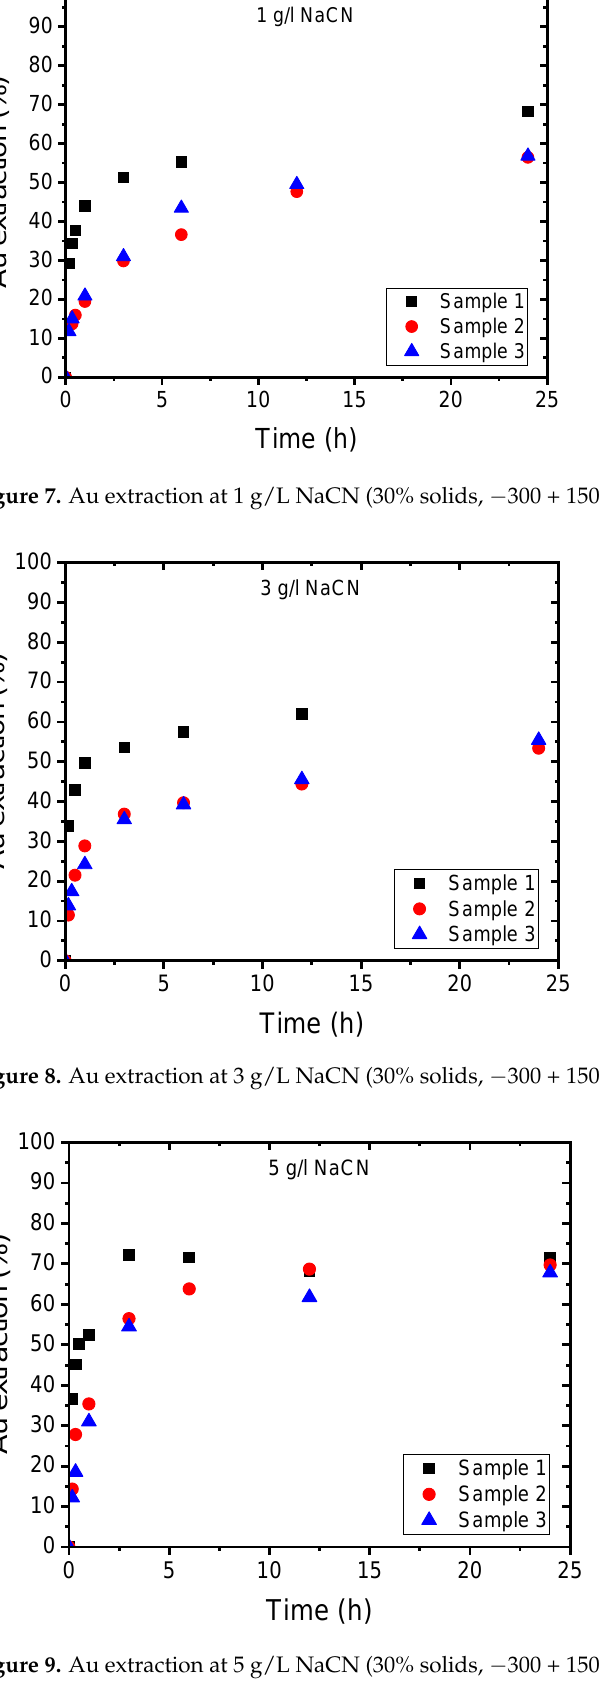
Figure 9. Au extraction at 5 g/L NaCN (30% solids, −300 + 150 µm PSD, 300 rpm, 26 °C). At 1 g/L NaCN, Sample 1 achieved the highest gold extraction at 68.2%, while Sample 2 and Sample 3 achieved 56.4% and 56.8%, respectively, after 24 h of leaching. At 3 g/L NaCN, Sample 1 still achieved the highest extraction at 62.0%, while Sample 2 and Sample 3 achieved 53.4% and 55.4%, respectively. Extractions at 3 g/L NaCN appear to be slightly lower than those achieved at 1 g/L NaCN. It should be noted that for Sample 1, at 3 g/L NaCN, gold extraction data were plotted only up to 12 h of leach time, as the leach sample at the 24 h mark was lost. At 5 g/L NaCN, Sample 1 reached an extraction of 71.6% while Sample 2 and Sample 3 achieved 69.7% and 67.8%, respectively. It can be observed, how- ever, that there is a slight decrease in gold concentration for Sample 1 at 5 g/L NaCN after 3 h of leaching. Sample 2 and Sample 3 (the higher-grade ores) showed similar initials kinetics at the three cyanide concentrations. 3.2.2. Reasons for Low Au Extractions The presence, in the three ores, of sulphide minerals that host gold can be a major reason for the low gold extractions achieved, since any gold hosted by these minerals would be locked and difficult to recover by conventional cyanidation. This was in fact confirmed by the diagnostic leach results which showed that, by the action of acids, the gold locked in sulphides could be extracted. In addition, sulphides of copper and iron such as pyrite, arsenopyrite, and chalcopyrite, which have been shown to be present in these ores (Figure 4), can consume cyanide by forming cyanide complexes and converting free cyanide ions to cyanate and thiocyanate, leading to cyanide losses [38]. This cyanide consumption could be a reason, as well, for the leaching only improving at the higher cyanide concentration of 5 g/L as opposed to the experiment at 3 g/L NaCN, whereby Au extraction did not improve from the 1 g/L NaCN experiment. Passive aeration, which was used in the leach tests to mimic ASM conditions, could also have impacted the process negatively since not enough oxygen was present. A comparison of the gold extracted by the diagnostic leach (after stage 2, which leached unlocked gold) and the cyanide leach of fresh samples (Figure 9) is shown in Fig- ure 10 alongside the head grades of the three samples. The cyanide leach of fresh samples at 5 g/L NaCN extracted free milling gold while the diagnostic leach was able to extract gold locked in sulphides by the successive action of aggressive acid and cyanide leach stages. In fact, when the total gold amounts extracted by both leach methods are added, the values obtained are within 20% of the respective head grades of the samples. This,